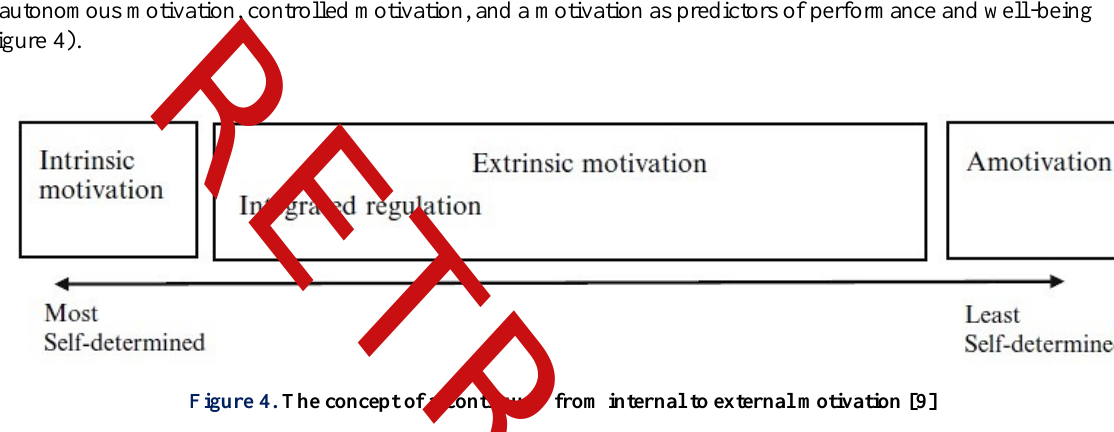
Figure 4. The concept of a continuum from internal to external motivation [9]